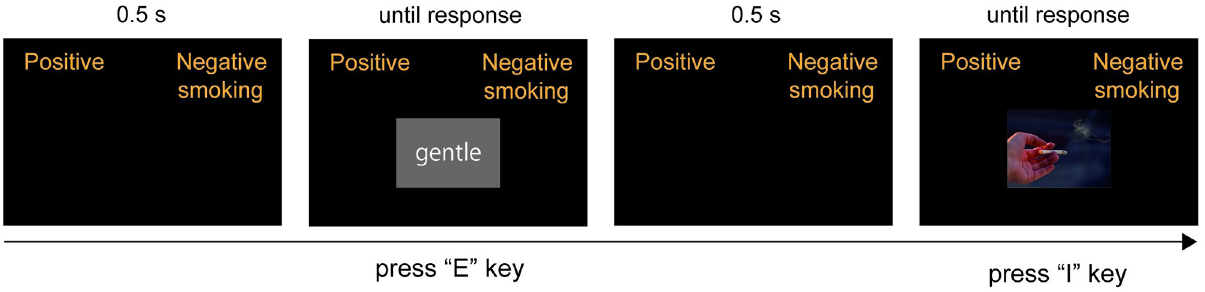
Fig 1. Schematic figure of the single category implicit association test (SC-IAT). Interstimulus interval was set at 0.5 s and stimuli were presented until subjects’ response. If subjects make an error, a red “X” is presented in the center, and they are required to correct their answer. All words were presented in